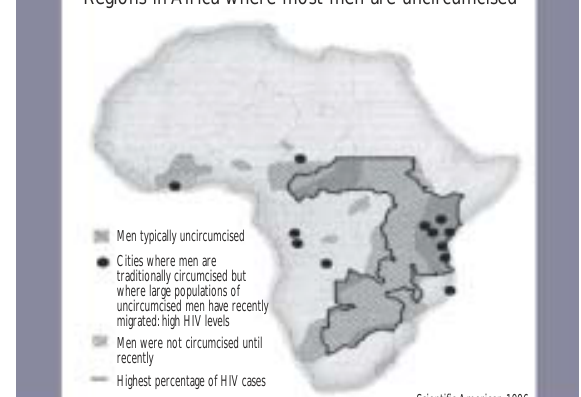
Fig. 1. Male circumcision and HIV in